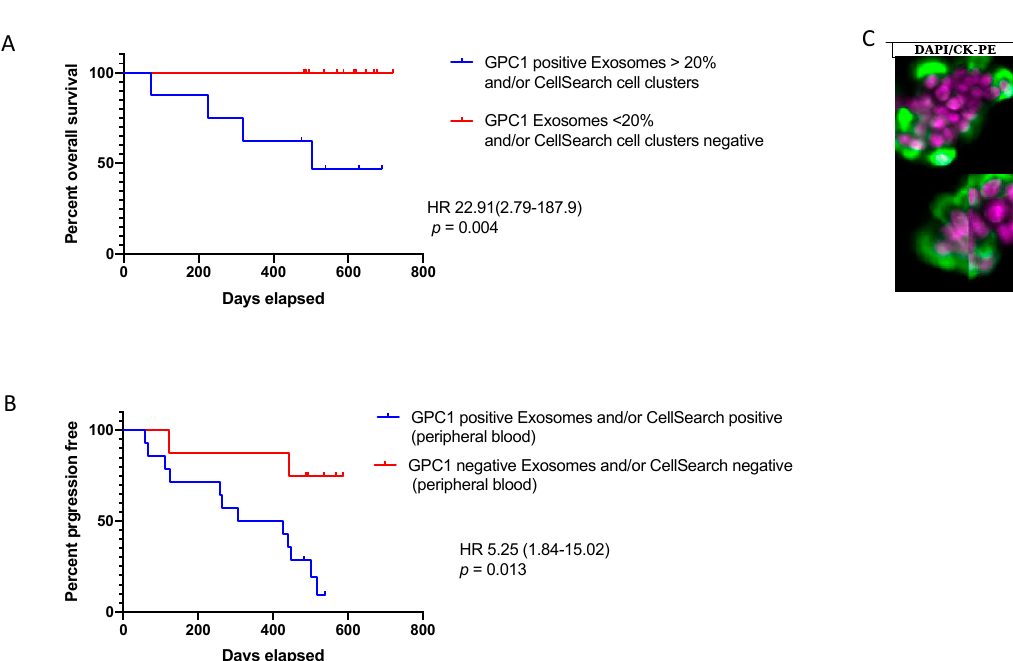
Figure 3. Analysis of GPC1-positive-exosome quantification and CellSearch ® positive CTC count and clusters according to clinical criteria. Kaplan–Meier curves, with p values (log Rank) for comparison between ( A ) overall survival (OS) for patients with >20% GPC1-positive exosomes (4 times the median value) and/or with CTC clusters and patient with <20% GPC1-positive exosomes and/or CellSearch ® without CTC clusters. ( B ) Progression-free survival (PFS) for patients with GPC1-positive exosomes and/or CellSearch ® positive and GPC1-negative exosomes and/or CellSearch ® negative in peripheral blood. ( C ) Immunofluorescent staining image of captured CTC clusters. Circulating tumor cell clusters captured from a portal vein sample using the CellSearch system. (CK, cytokeratin; PE, phycoerythrin; DAPI, 4 ′ ,6-diamidino-2-phenylindole; DAPI stain is purple and CK stain is green, (original magnification ×400)).